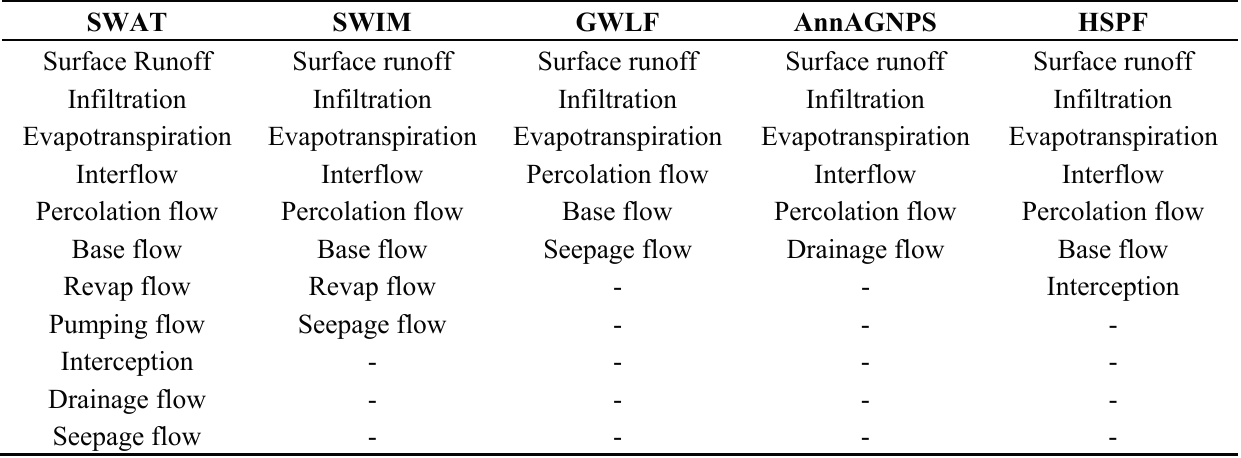
Figure 1. Hydrology/hydrogeology processes considered by common process-based models. Table 1. Hydrological processes considered in the five